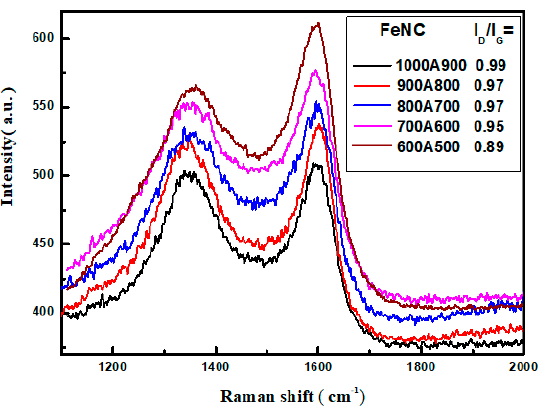
Figure 5. Raman spectra and I D /I G ratios of FeNCs prepared with different calcination methods.